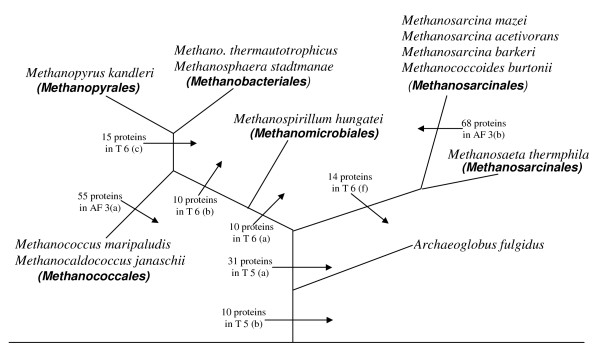
An interpretive diagram showing the evolutionary stages where genes for different proteins that are specific for methanogenic archaea likely originated. The 10 proteins that are uniquely shared by A. fulgidus and various methanogenic archaea indicate that this lineage is the closest ancestor of all methanogens.